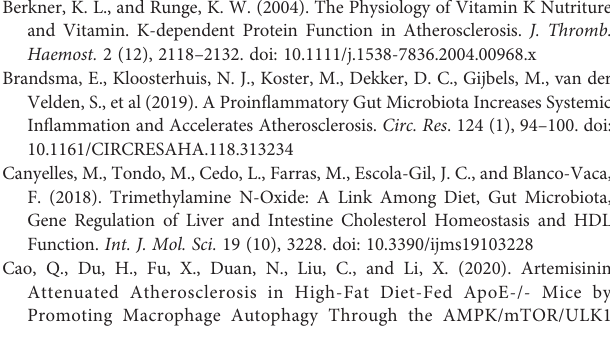
Supplementary Figure 1 | Speci fi c bacteria statistically signi fi cant between WT and AS, AS and AS+CIH. (A, B) Histogram of the LDA scores indicate bacteria differentially abundant between AS (red) and WT (green) at phylum (A) and genus (B) level. The LDA scores (log10) > 2 are listed. (C, D) LDA scores demonstrate phyla (C) and genera (D) that were signi fi cantly distinguished in AS mice (red) from the animals housed under CIH conditions (green). n=7 for WT, and n=8 for AS and